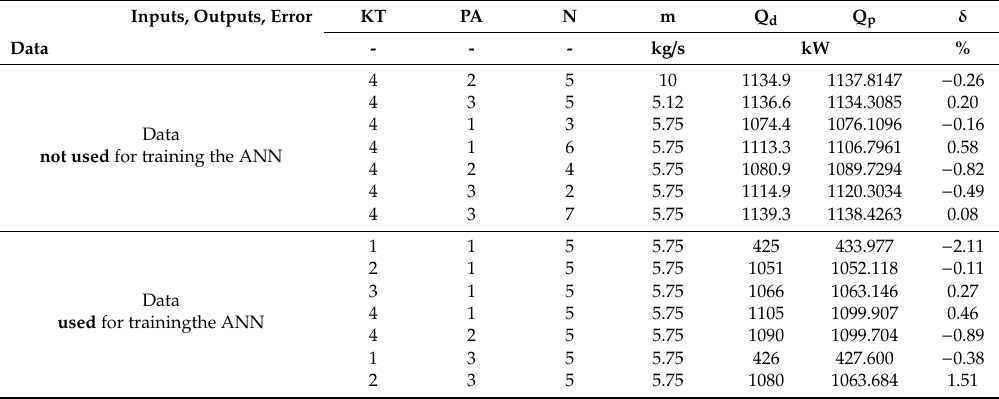
Table 5. The selected values of heat transfer rate desired Q d vs predicted Q p by the AGENN model. Inputs, Outputs, Error KT